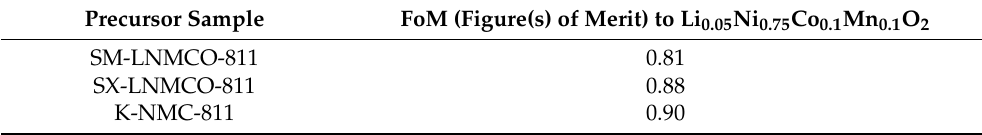
Table 4. The FoM of the three precursors to Li 0.05 Ni 0.75 Co 0.1 Mn 0.1 O 2 . Precursor Sample